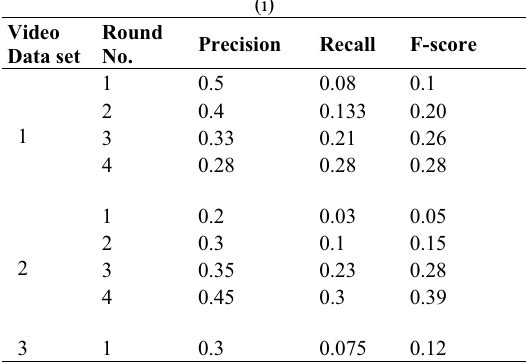
Table. 1. Precision-recall and F-score values for CBVR system (i) with Motion pattern (ii) with motion feature and RGB color model (iii) with histogram features and (iv) with extensive feature set for normal